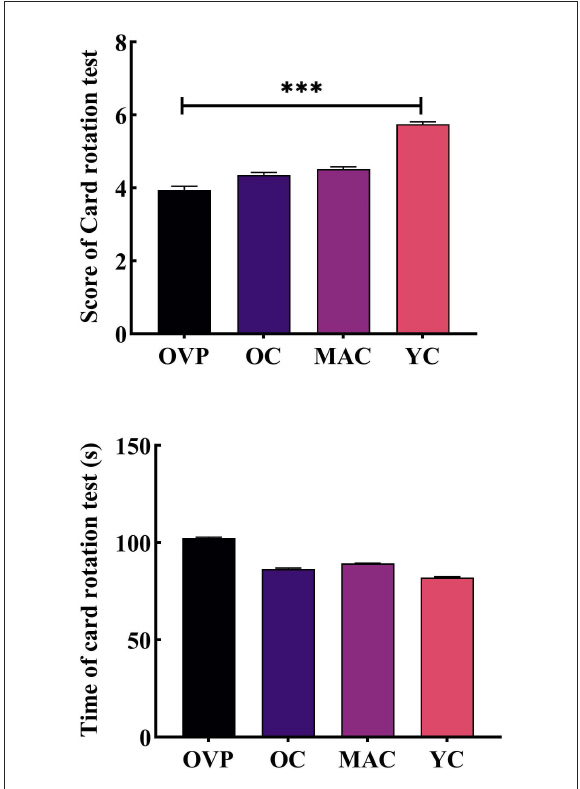
FIGURE6 Score and time of Card rotation test between groups. (A) Score of card rotation test. (B) Time of card rotation test. Post-hoc multiple comparisons between groups using OVP group as reference, significantly differences were indicated by the asterisk. OVP, Older vertigo patients; OC, Older controls; MAC, Middle-aged controls; YC, Young controls. *** p < 0.001. Error bars indicate the SEM.